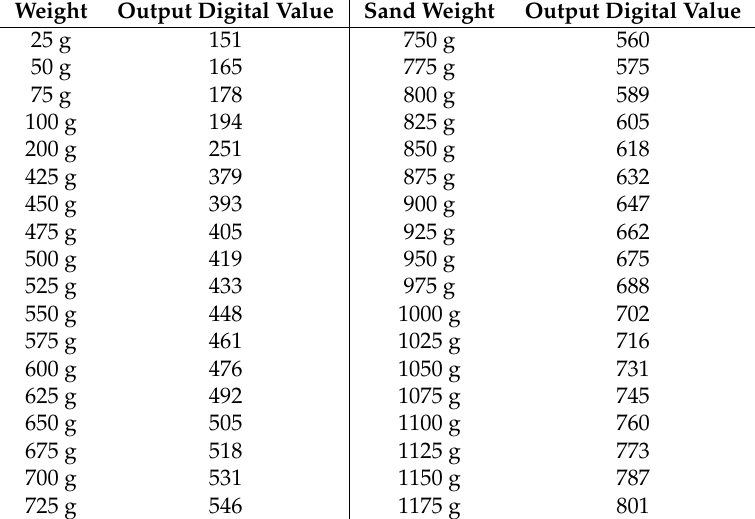
Table 1. Measured data for the calibration of the load